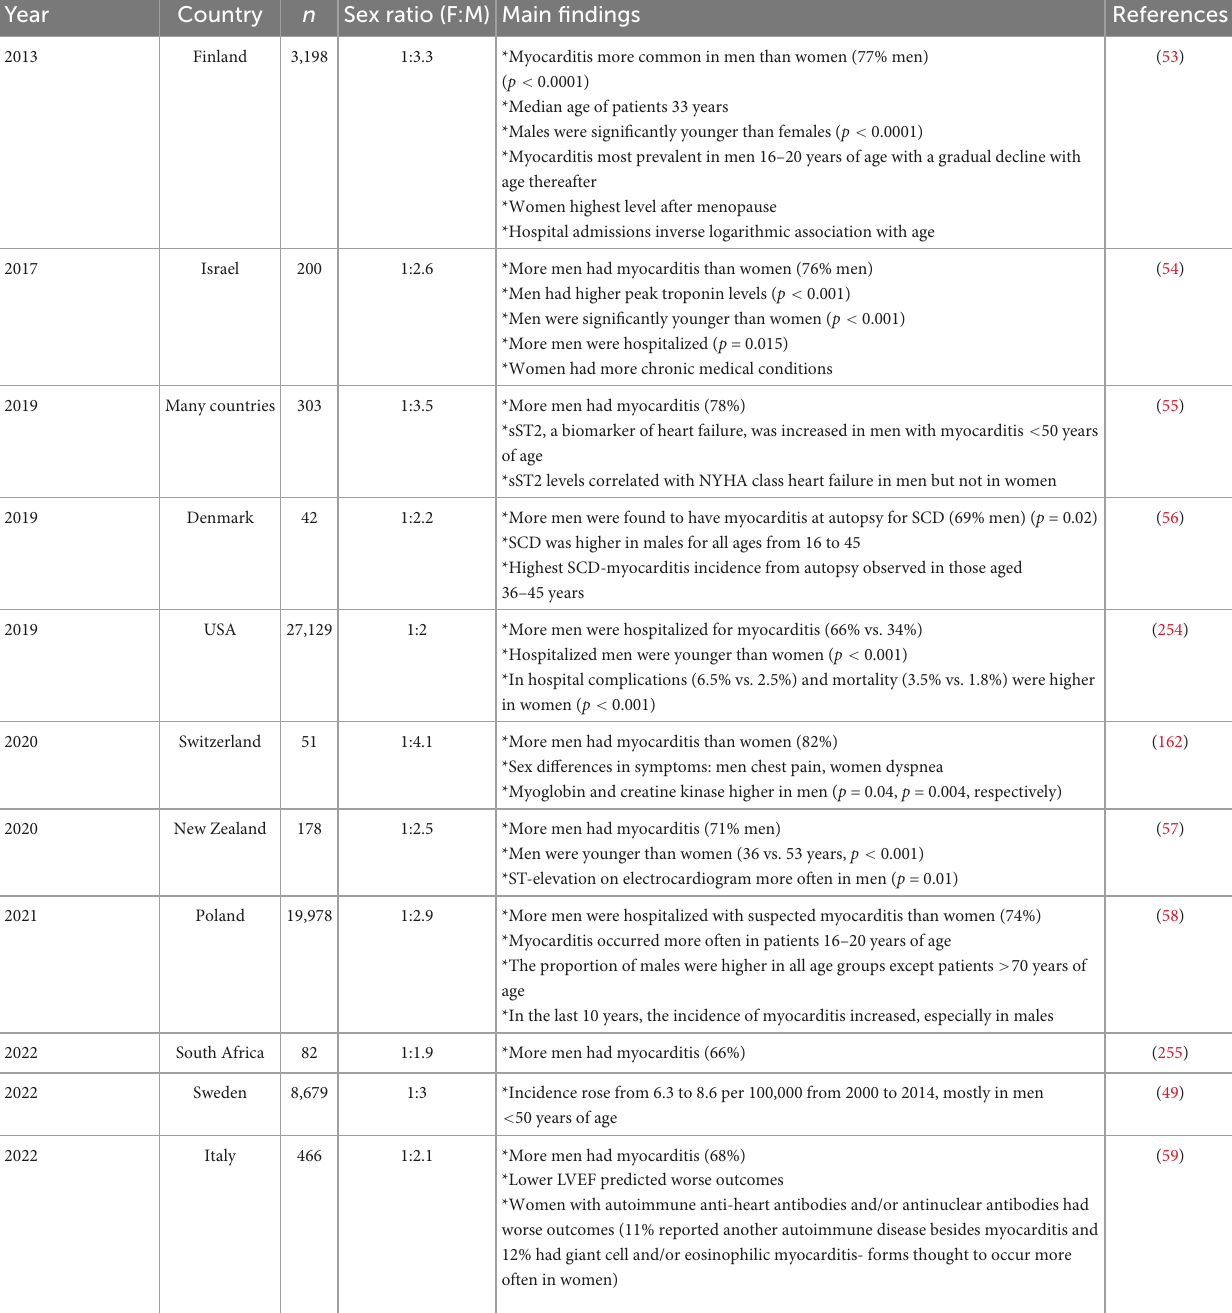
TABLE 1 Studies of sex differences in myocarditis in the past